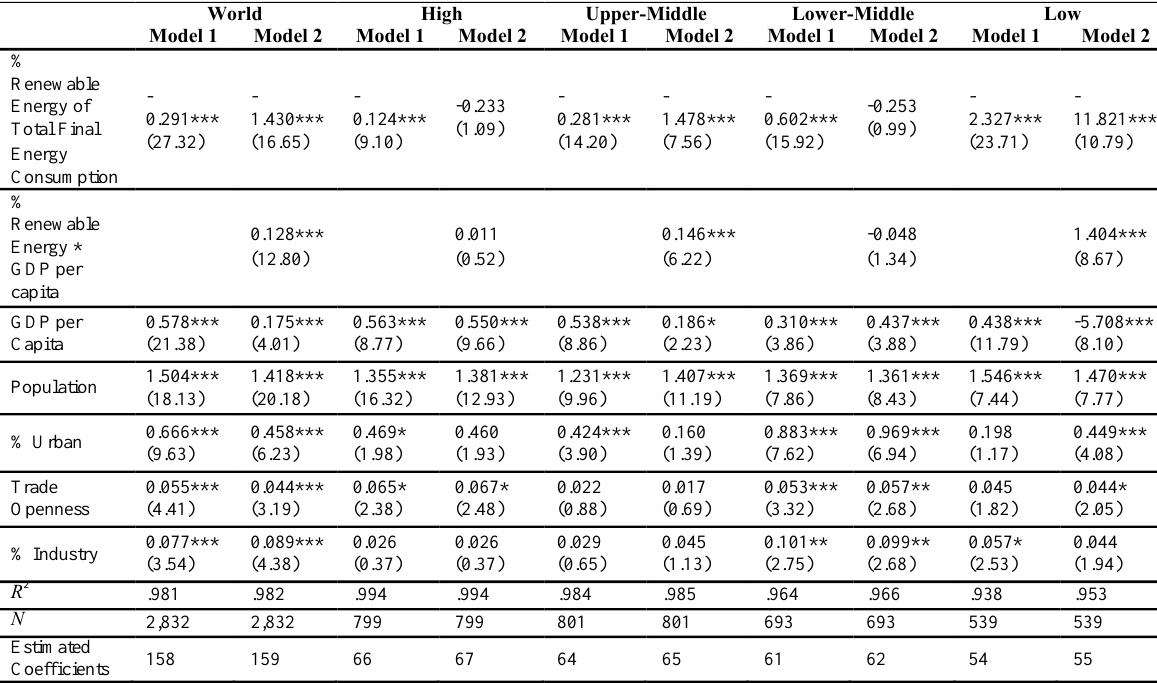
Table 2. Unstandardized Coefficients for the Regression of Total Carbon Dioxide Emissions, 1990-2013: PW Regression Model Estimates with PCSE and an AR (1)